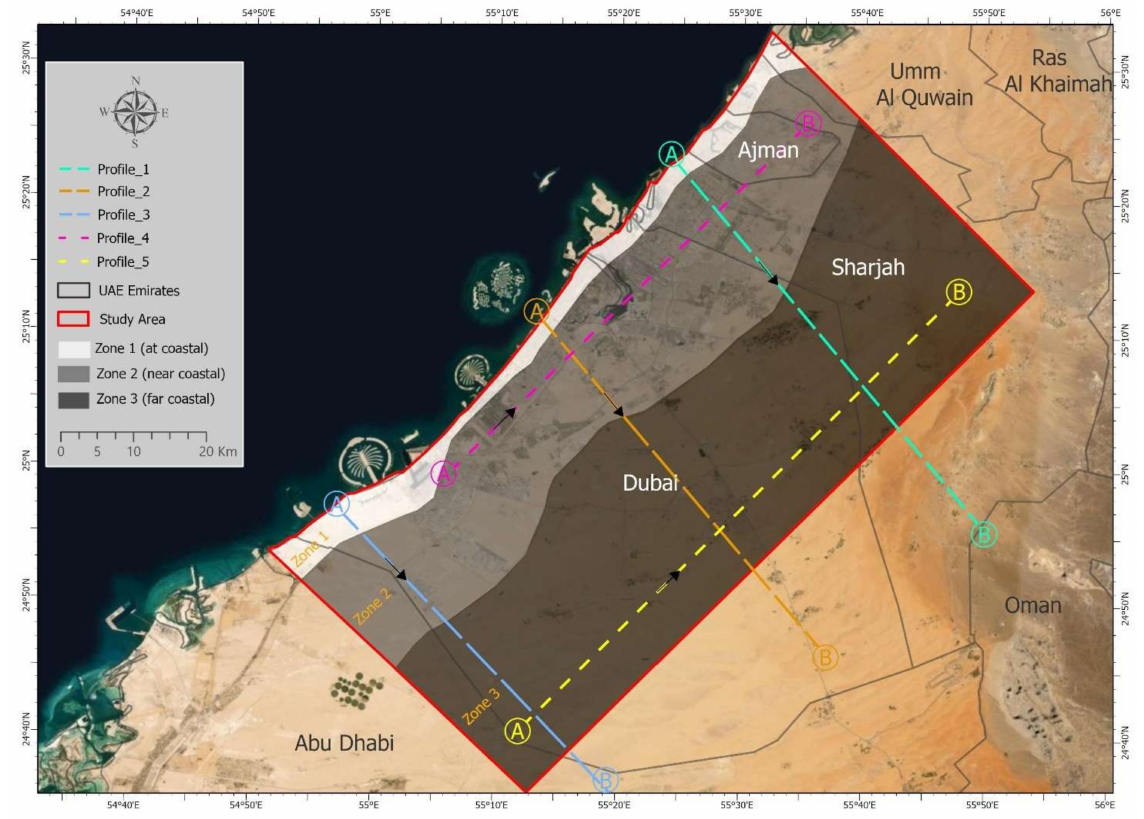
Figure 12. Location of Day LST Path in the Study